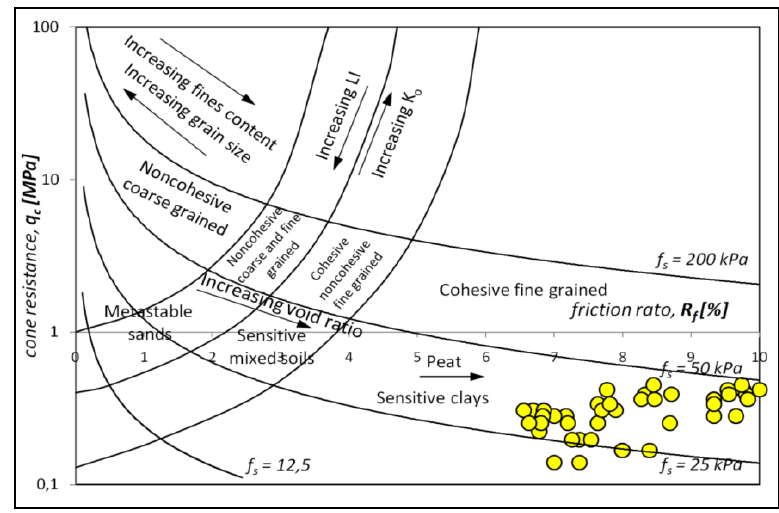
Figure 4. Diagrams present the identification of organic soils based on CPTM tests, according to the propositions of Olsen’s nomogram.